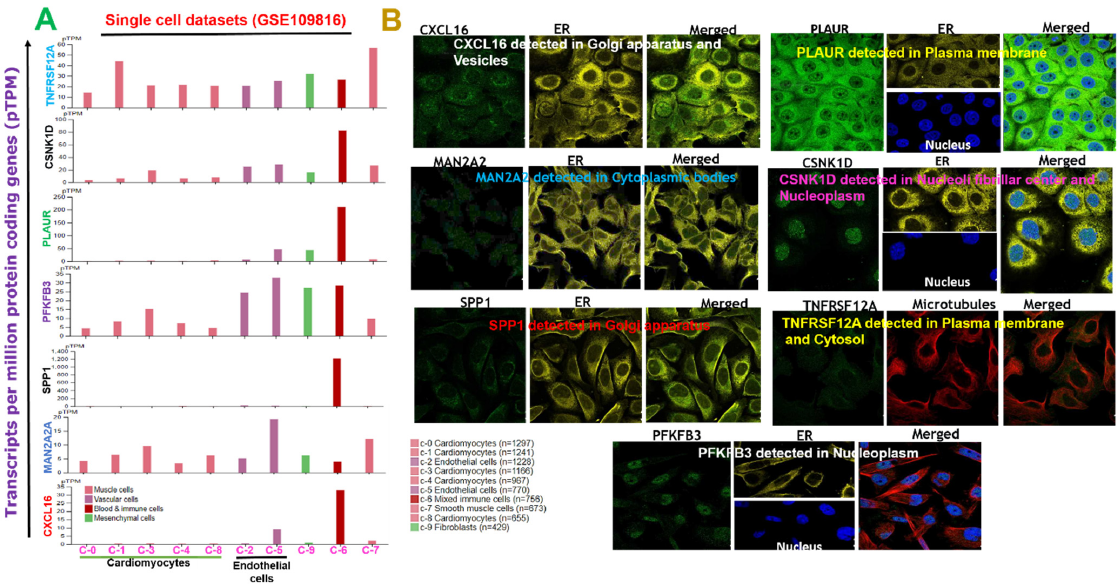
Figure 3. Subcellular localization of proteins and single-cell transcriptomic data of differentially ex- pressed genes (DEGs) in the adult human heart during myocardial infarction. ( A ) Bar plots of single- cell transcriptomic data of the DEGs in different cells during myocardial infarction. ( B ) Immunoflu- orescence staining of the subcellular distributions of target proteins within the nucleus and endo- plasmic reticulum (ER) of cells. Immunofluorescence staining was adopted from the HPA database.